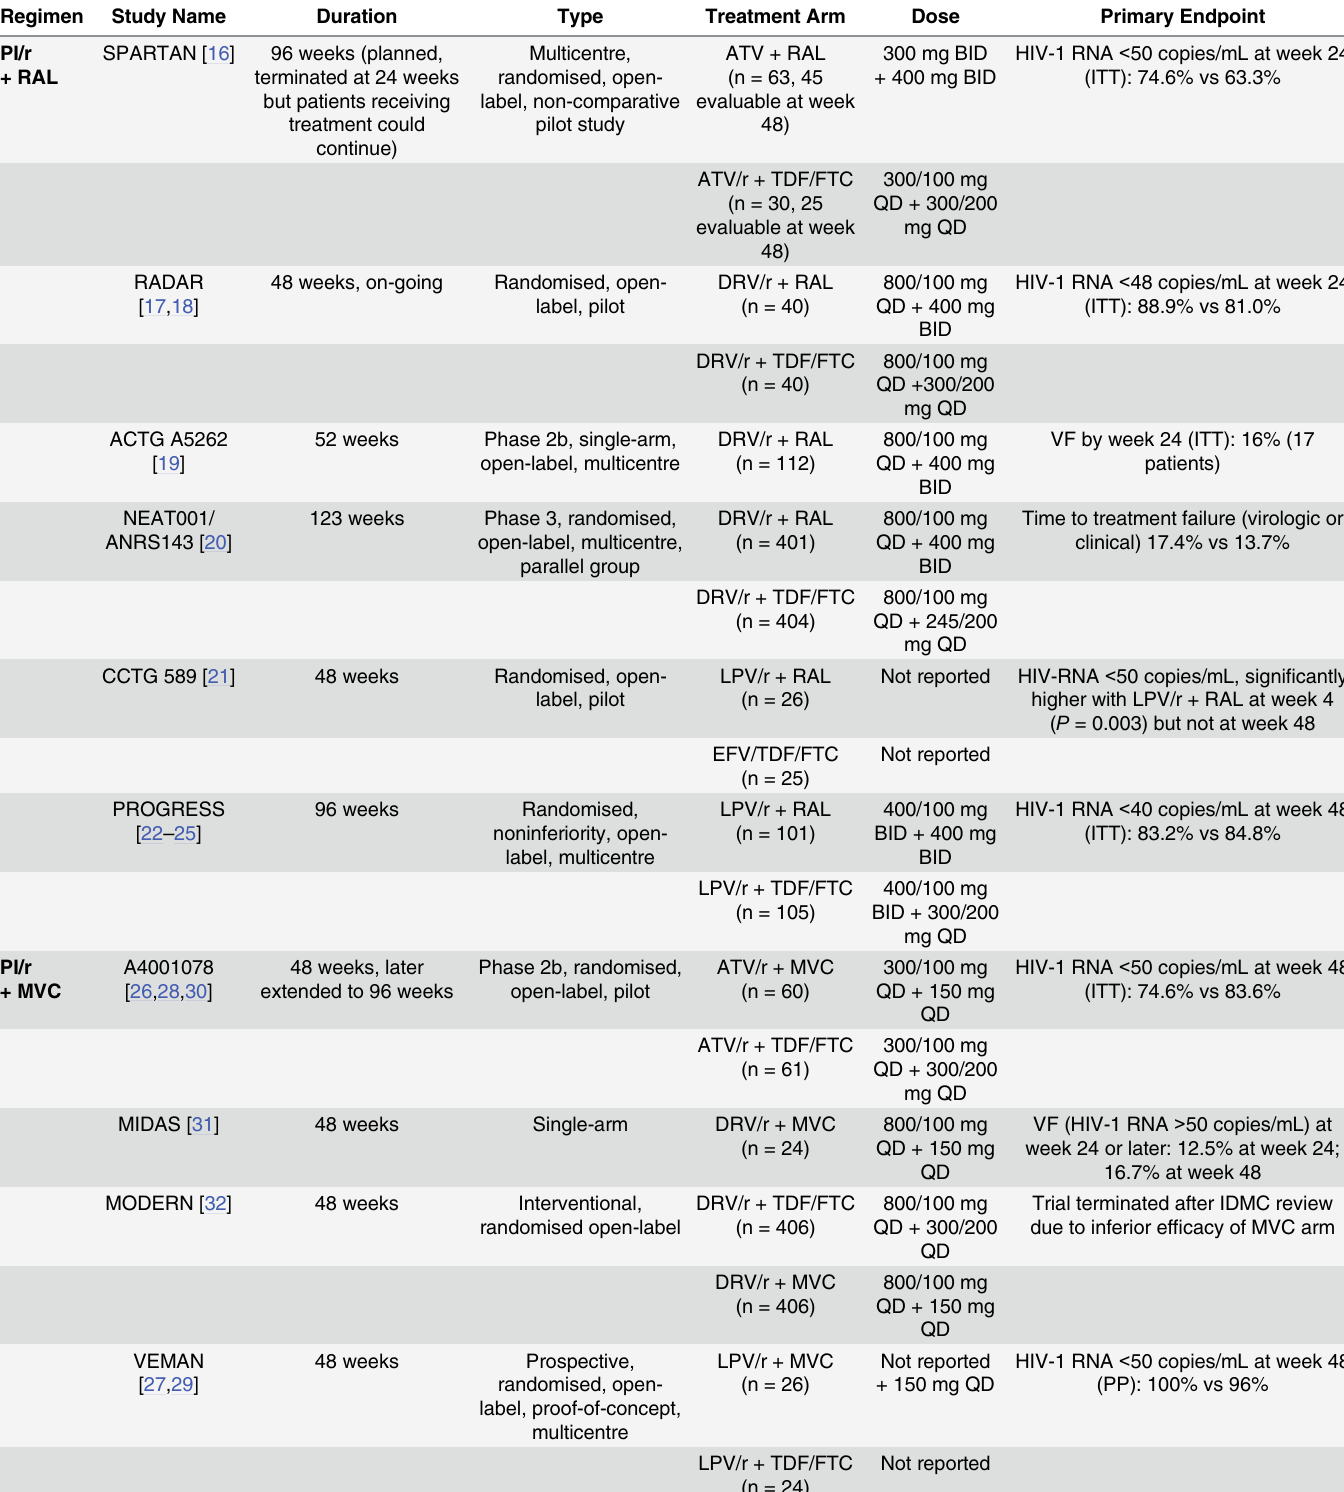
Table 1. Study designs for identified trials in ARV-naive